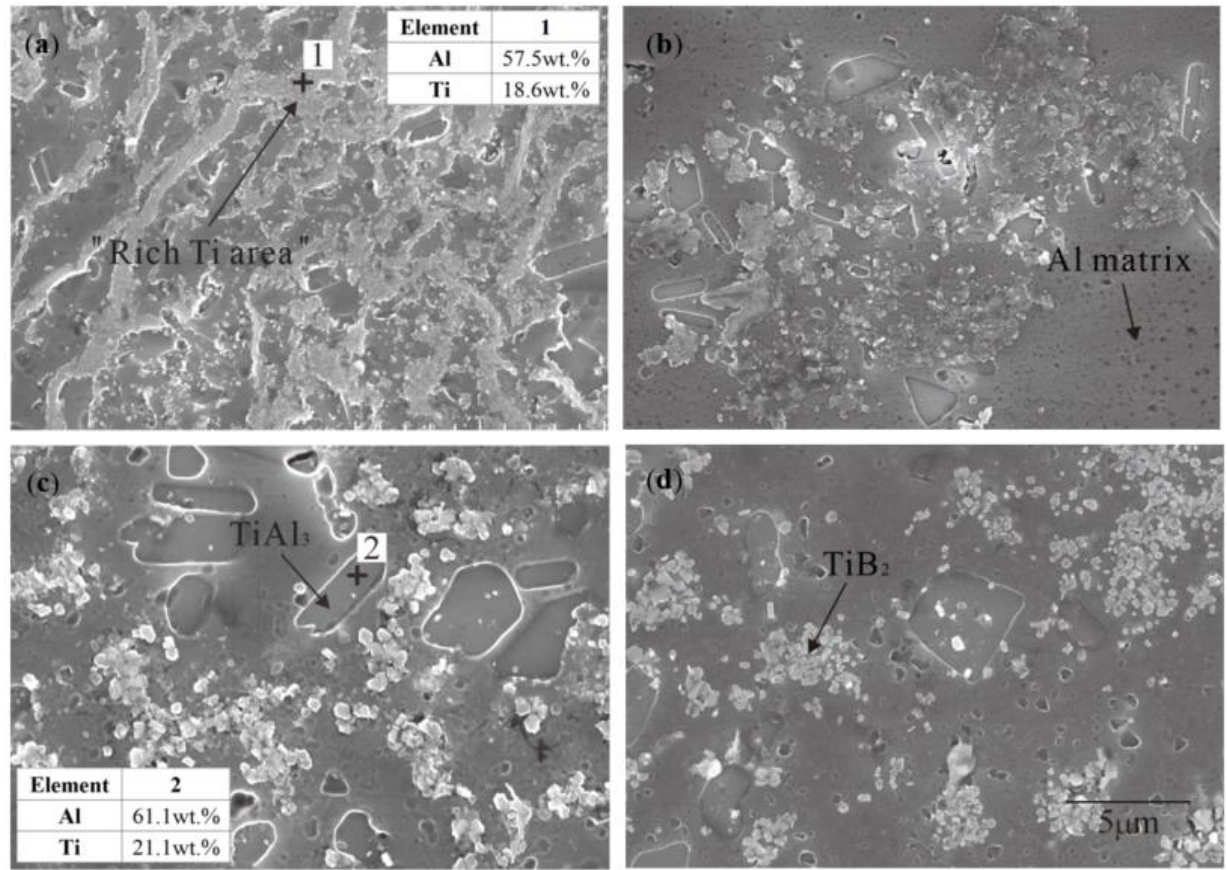
Figure 1. Microstructure and EDS of Al–Ti–B Master Alloy prepared by the halide salt route with different reaction times at 800 °C: ( a ) 10 S; ( b ) 30 S; ( c ) 60 S; ( d ) 600 S.